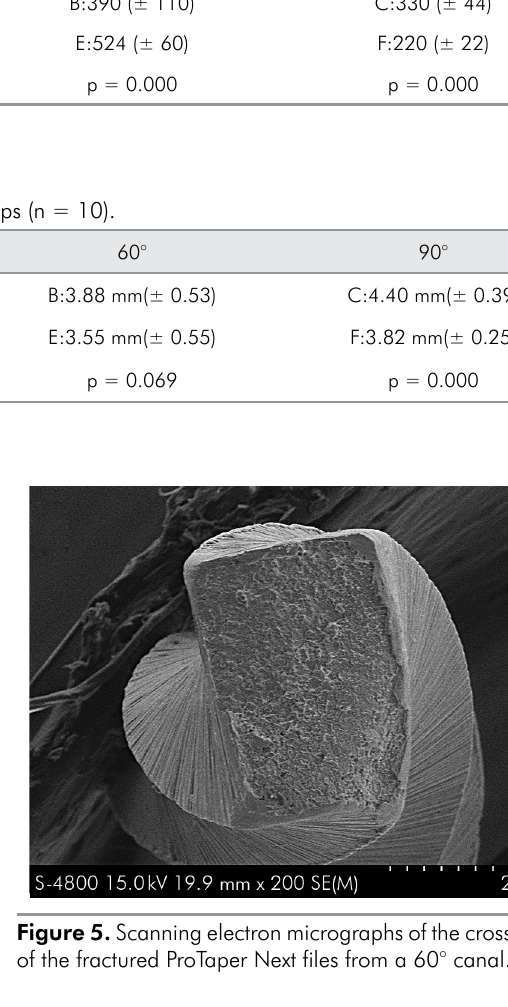
Table1. Mean (± SD) of the NCF (n = 10) for different groups. Groups